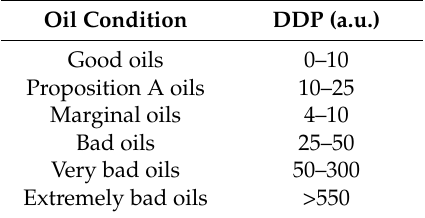
Table 5. Guidelines for dissolved decay products (DDPs)